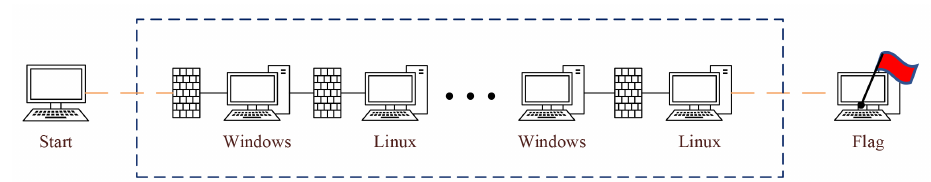
Figure 10. CyberBattleChain Experimental Scenario.